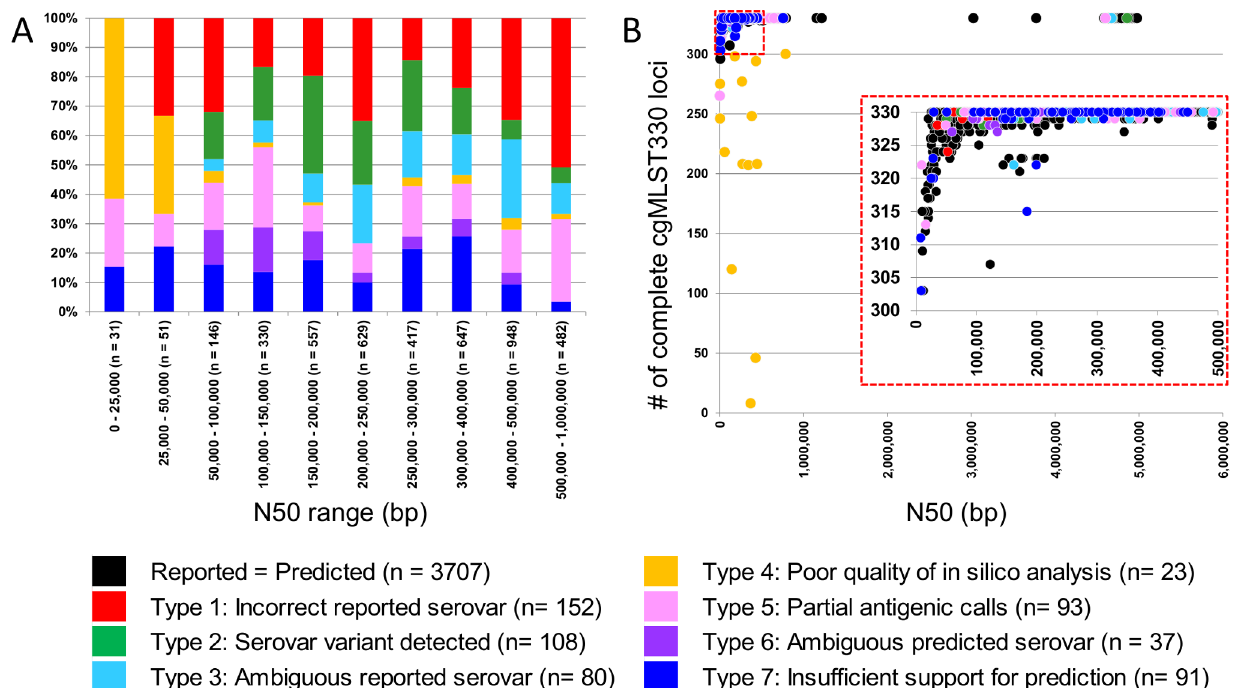
Fig 3. The SISTR serovar prediction logic can robustly yield accurate predictions for a range of genome qualities. (A) The relative proportion of various error types does not change appreciably as a function of the N50 assembly quality parameter. Type 4 errors, which are related to poor cgMLST330 metrics, are only observed among genomes with lowest N50 values. (B) Although large numbers of missing cgMLST330 loci affect serovar prediction, as observed with errors of Type 4, accurate predictions were also made for genomes with as few as 296 complete cgMLST330